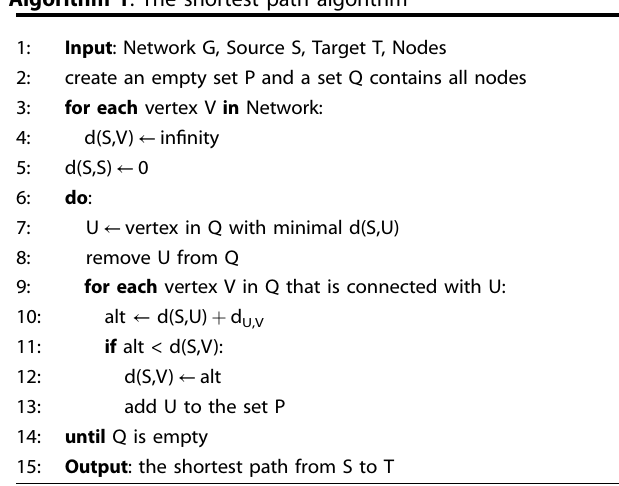
Algorithm 1 . The shortest path algorithm 102